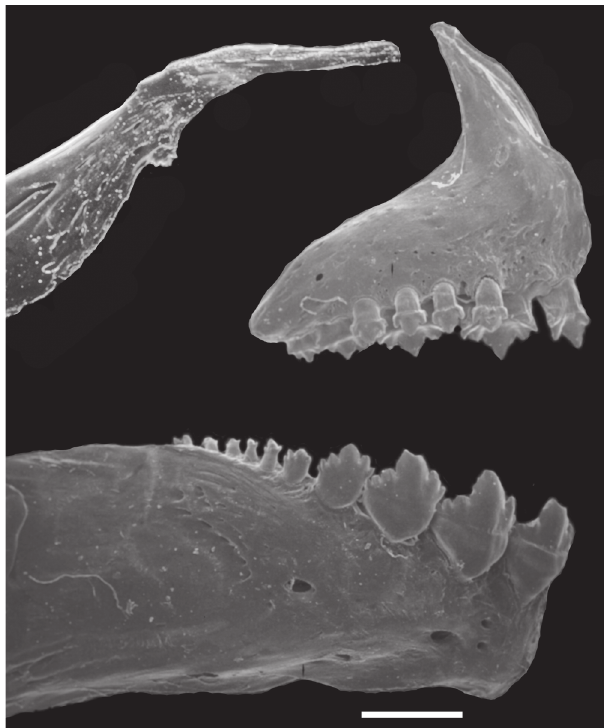
Fig. 8. Astyanax xiru , new species, MCP 33580, 70.5 mm SL, paratype, upper and lower jaws teeth, left side, lateral view. Scale bar = 1